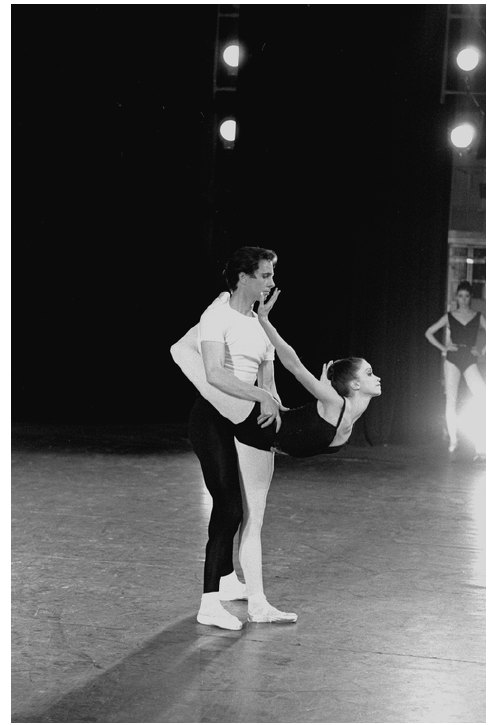
Figure 4. Agon duet with Kay Mazzo and Frank Ohman, 1969. Photo © Martha Swope and New York Public Library, used with permission. Public Library, used with